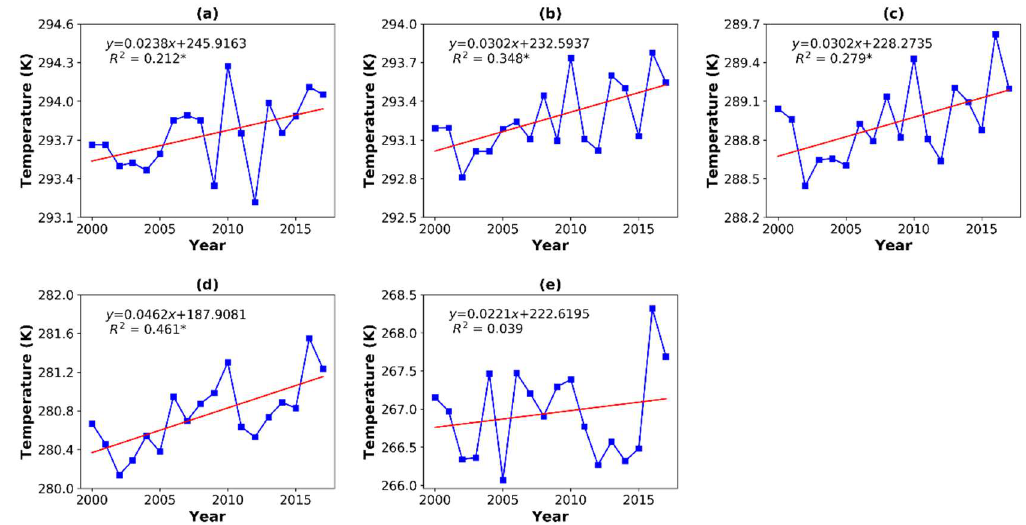
Figure 5. Temporal variation and linear trend of the average nighttime MAST in the ( a ) Terai Plain, ( b ) Siwalik Hills, ( c ) Middle Mountains, ( d ) High Mountains, and ( e ) High Himalaya during the period from 2000 to 2017. (*Significant at a 95% confidence level).